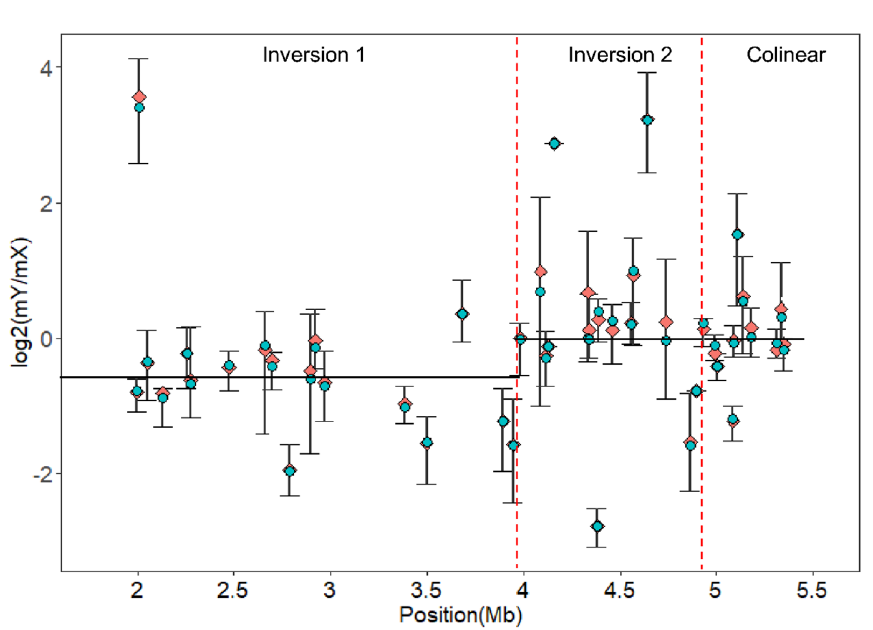
Figure 4. The distribution of log 2 transformed expression ratio of Y alleles relative to X alleles in male samples (including three leaf replicates and five flower replicates) across the non-recombining region. Forty-five pairs of expressed genes were used in the analysis, including 18 genes in inversion 1, 16 genes in inversion 2, and 11 genes in the collinear region. The X-axis represents the position of genes in the non-recombining region of the X chromosome. Cyan and orange dots represent the log 2 value of average and median ratios between Y and X alleles,